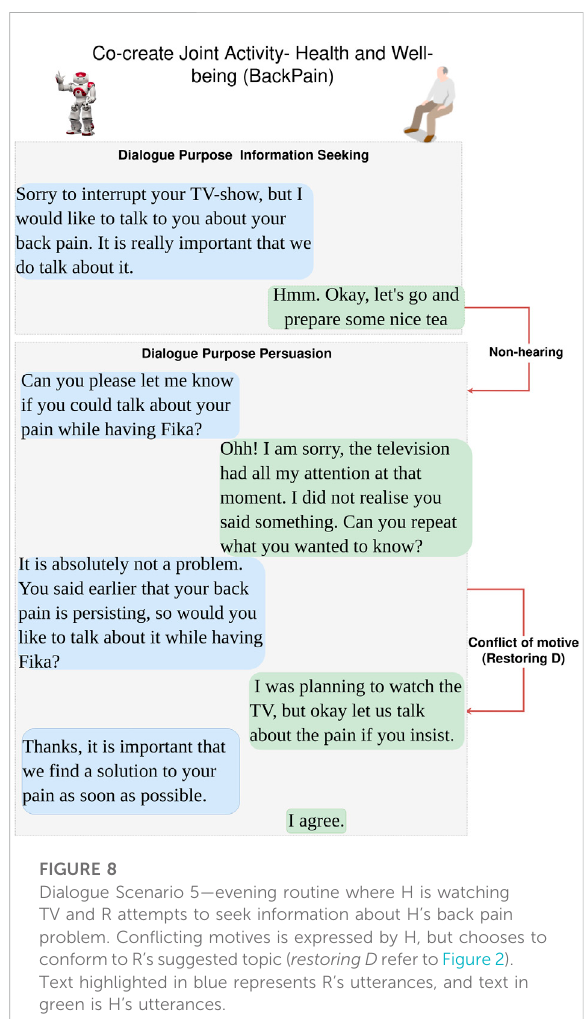
FIGURE 8 Dialogue Scenario 5 — evening routine where H is watching TV and R attempts to seek information about H ’ s back pain problem. Con fl icting motives is expressed by H, but chooses to conform to R ’ ssuggested topic( restoring D refer toFigure 2). Text highlighted in blue represents R ’ s utterances, and text in green is H ’ s